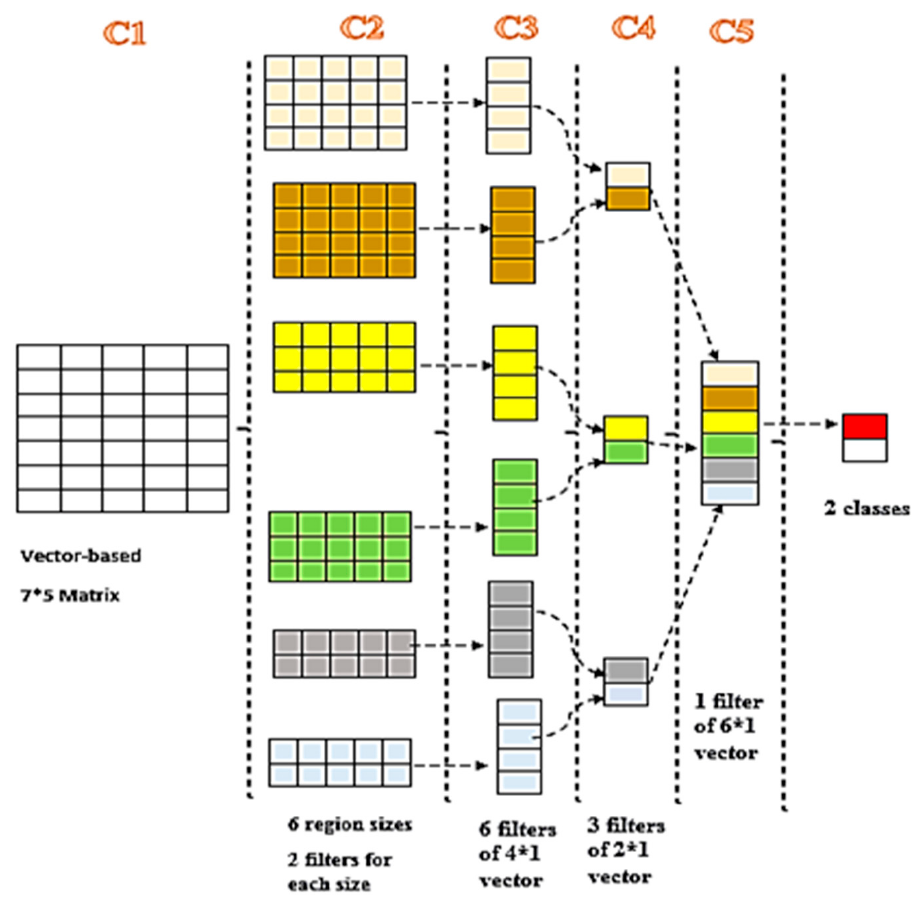
Figure 9. The DL phase in the HSAS-MD.